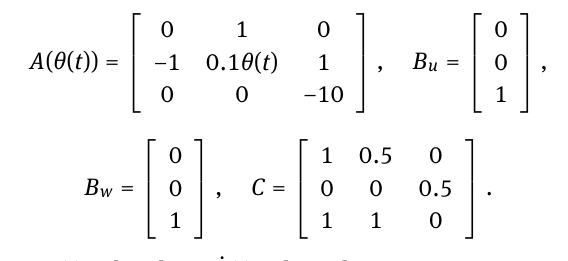
Table 4: Number of LMI variables and number of LMI rows for Theo- rem 1 (Example 2).